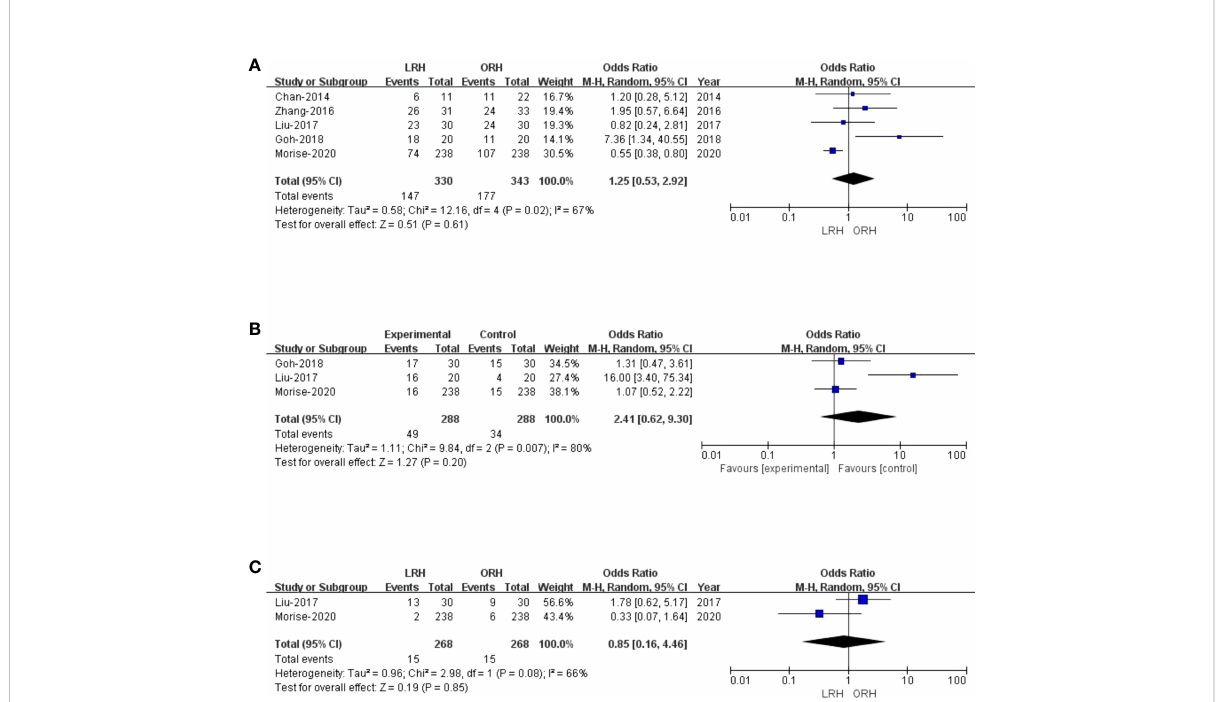
FIGURE 5 Forest plot of comparison of LRH versus ORH for the recurrence-free survival rate of survivors (A) , Forest plot for 1-year recurrence-free survival rate; (b) , Forest plot for 3-year recurrence-free survival rate; (C) , Forest plot for 5-year recurrence-free survival